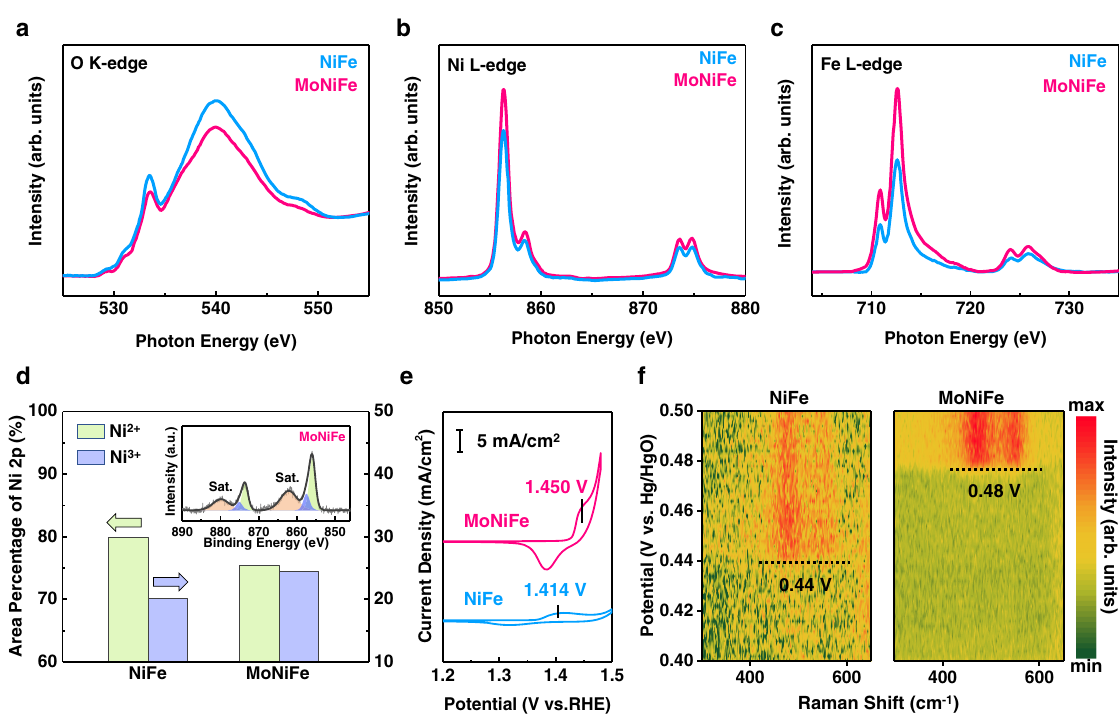
Fig. 6 Lattice oxygen activity determined by advanced spectroscopy techniques. a O K-edge, b Ni L-edge, and c Fe L-edge soft X-ray absorption spectroscopies (sXAS) of NiFe and MoNiFe (oxy)hydroxide. The step at the background of O K-edge spectra was normalized to be 1 46 . The background of Ni L-edge and Fe L-edge spectra were subtracted. The raw data and the background of sXAS spectra are shown in Supplementary Fig. 35-37. d Oxidation state of nickel in NiFe and MoNiFe (oxy)hydroxide determined by Ni 2 p X-ray photoelectron spectroscopy (XPS). The inset fi gure is the Ni 2 p XPS spectrum of MoNiFe (oxy)hydroxide. e Redox peaks of Ni in cyclic voltammetry (CV) curves of NiFe and MoNiFe (oxy)hydroxide. f In-situ Raman spectra map of NiFe and MoNiFe (oxy)hydroxide acquired during CV measurement, in which the dash lines mark the required potential for driving the transition from Ni 2 + to Ni 3 +